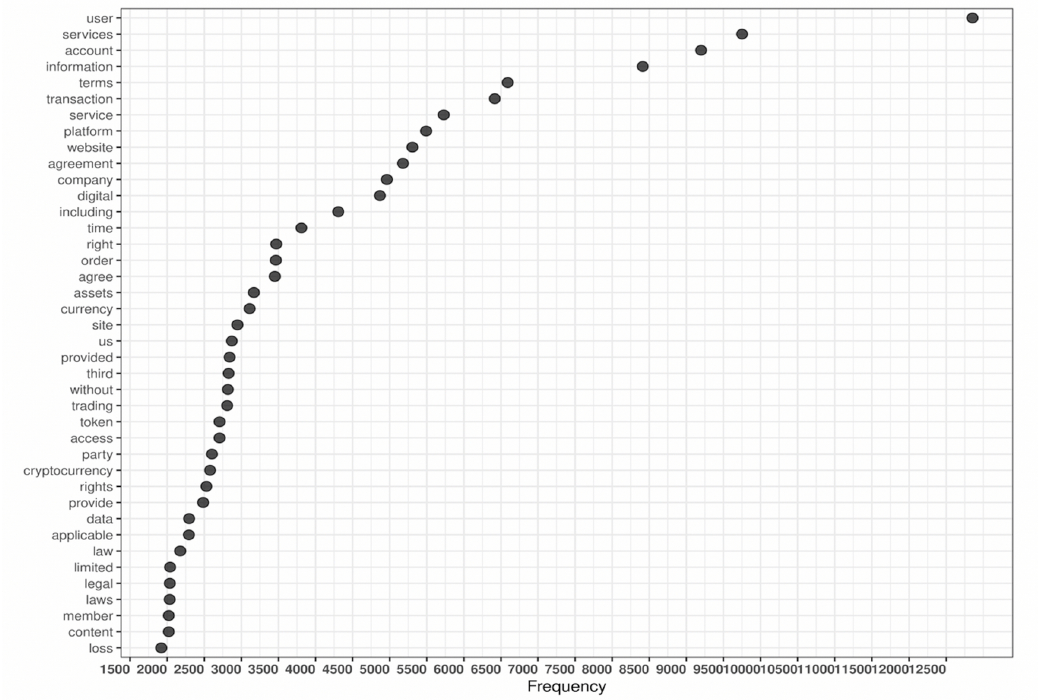
Figure 3: Frequency of Words Used in Terms of Service